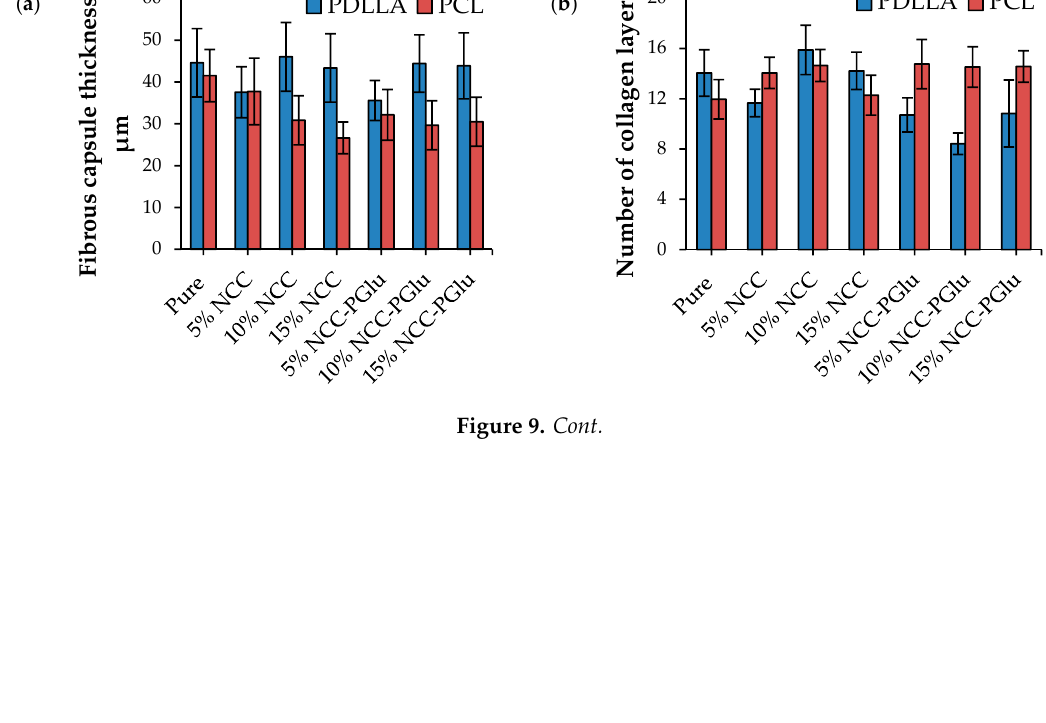
Figure 9. See cont. on next page.